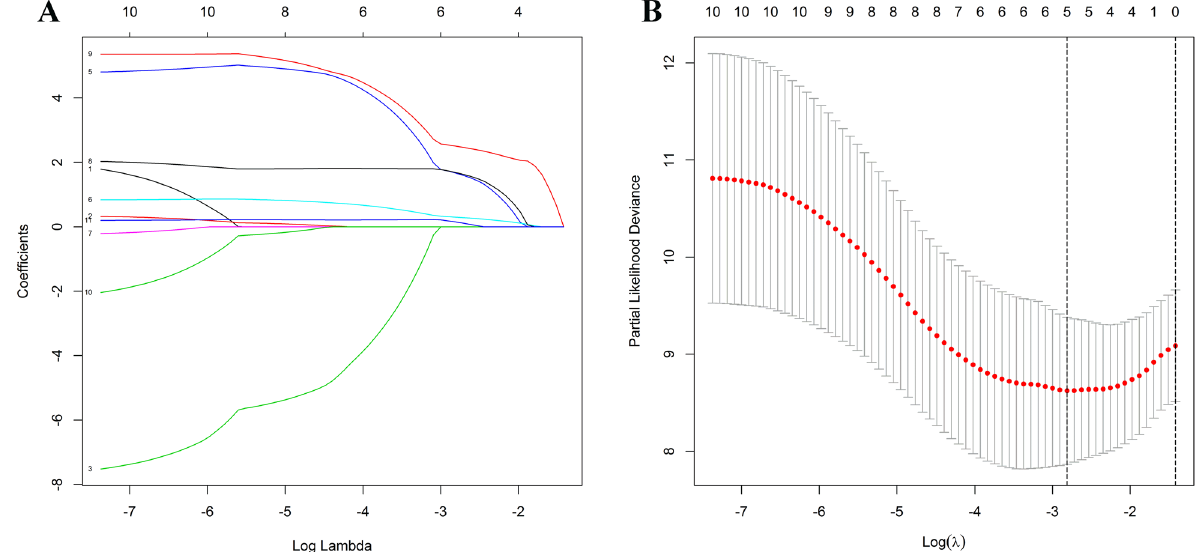
Figure 1. Construction of the risk signature in UM patients in the training cohort. Parameters were going to zero with the penalty (lambda) increasing in the objective function of the LASSO ( A ). 1, AIM2 ; 2, CASP1 ; 3, CASP5 ; 4, CASP8 ; 5, GSDMC; 6, GSDMD ; 7, IL18 ; 8, IL6 ; 9, NLRP6 ; 10, NOD2 ; 11, PLCG1 . Selection of the optimal variables (lambda) in the LASSO model ( B ). The figure was performed using R software (version 3.3.1, Vienna, Austria, https:// www.r- proje ct. org/).